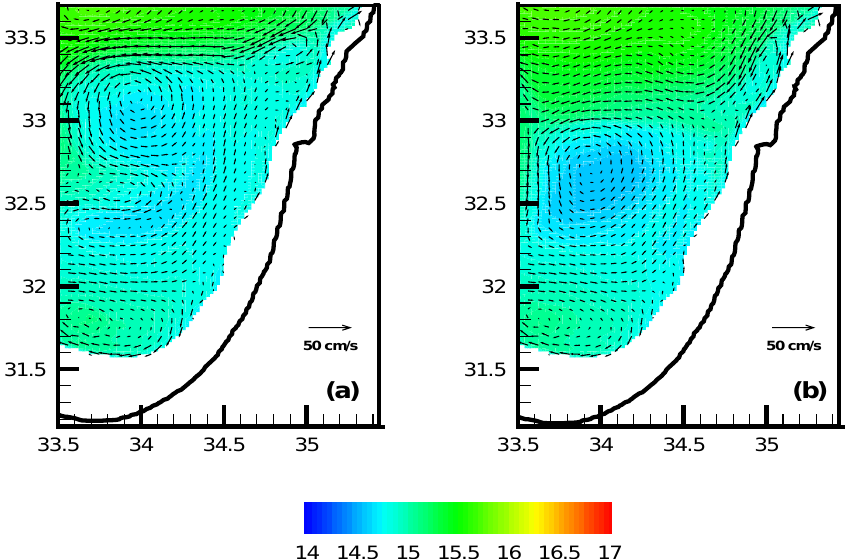
Fig. 6. Simulated potential temperature and velocity at 300m: (a) 20 August of the second year, (b) 20 August of the third